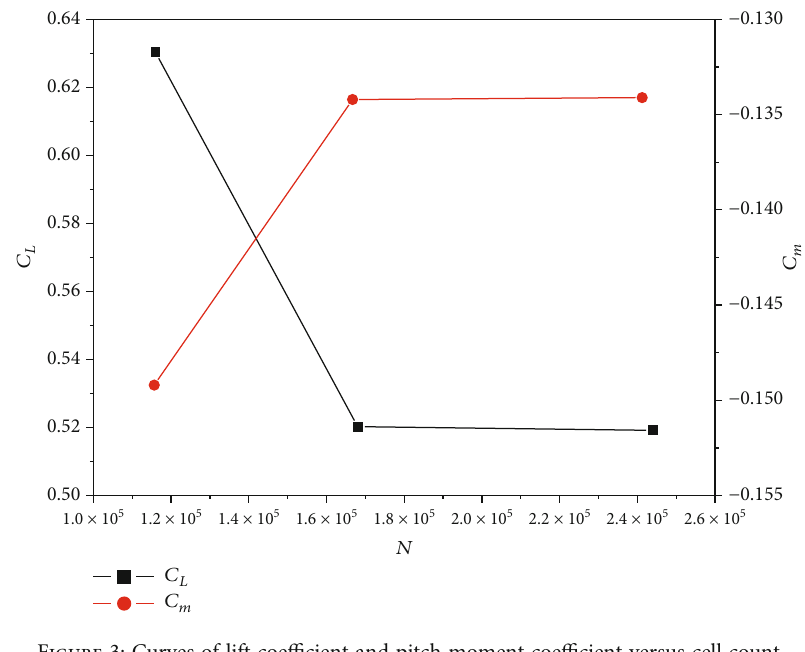
Figure 3: Curves of lift coe ffi cient and pitch moment coe ffi cient versus cell count.